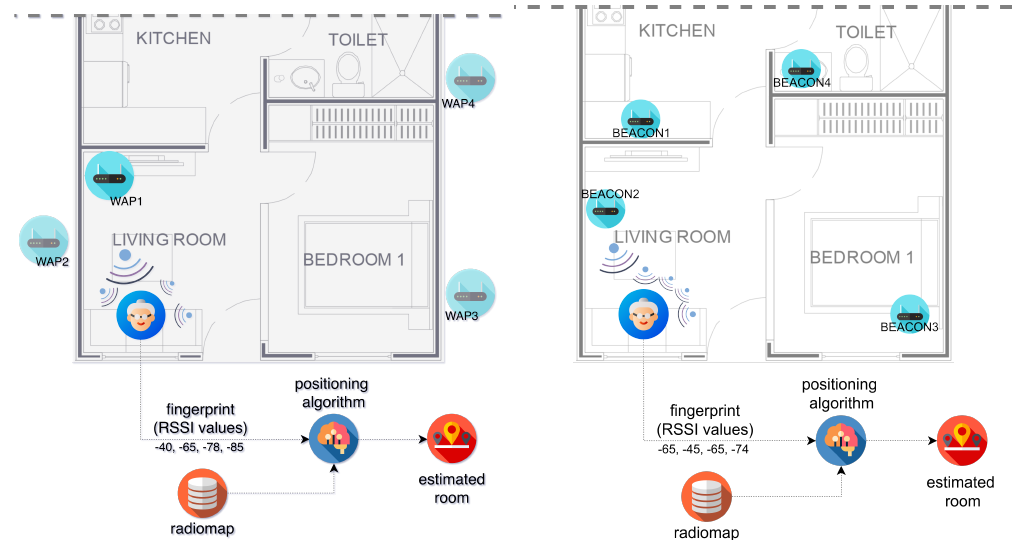
Figure 1. Schemes of the online phase of: a Wi-Fi fingerprinting IPS ( left ); and a BLE-based IPS ( right ). (Icons made by Freepik from